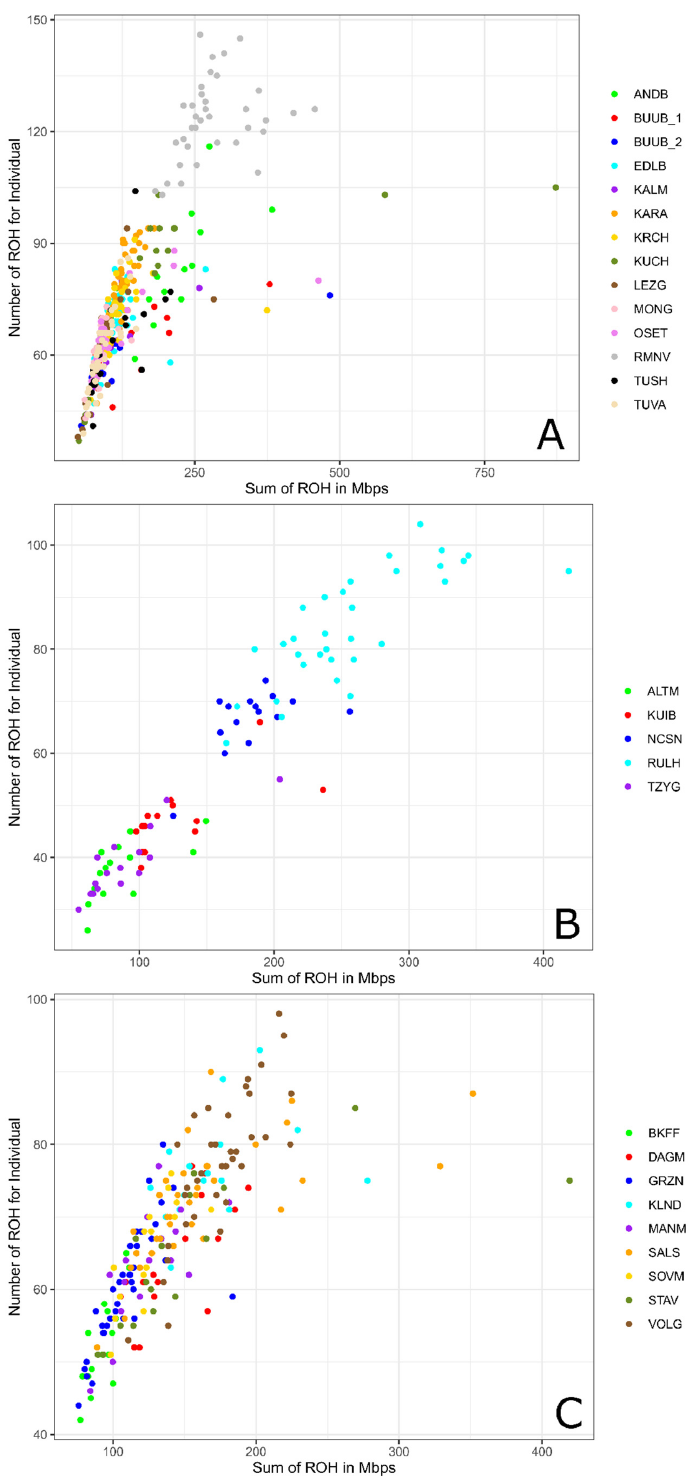
Figure 2. Genomic coverage in ROH (X-axis) and ROH number per individual (Y-axis) in Russian sheep breeds: ( A ) Genomic coverage in ROH (X-axis) and ROH number per individual (Y-axis) within the group of coarse wool breeds; ( B ) Genomic coverage in ROH (X-axis) and ROH number per individual (Y-axis) within the group of semi-fine wool breeds; ( C ) Genomic coverage in ROH (X-axis) and ROH number per individual (Y-axis) within the group of fine wool breeds. For a description of the sheep breeds, see Table